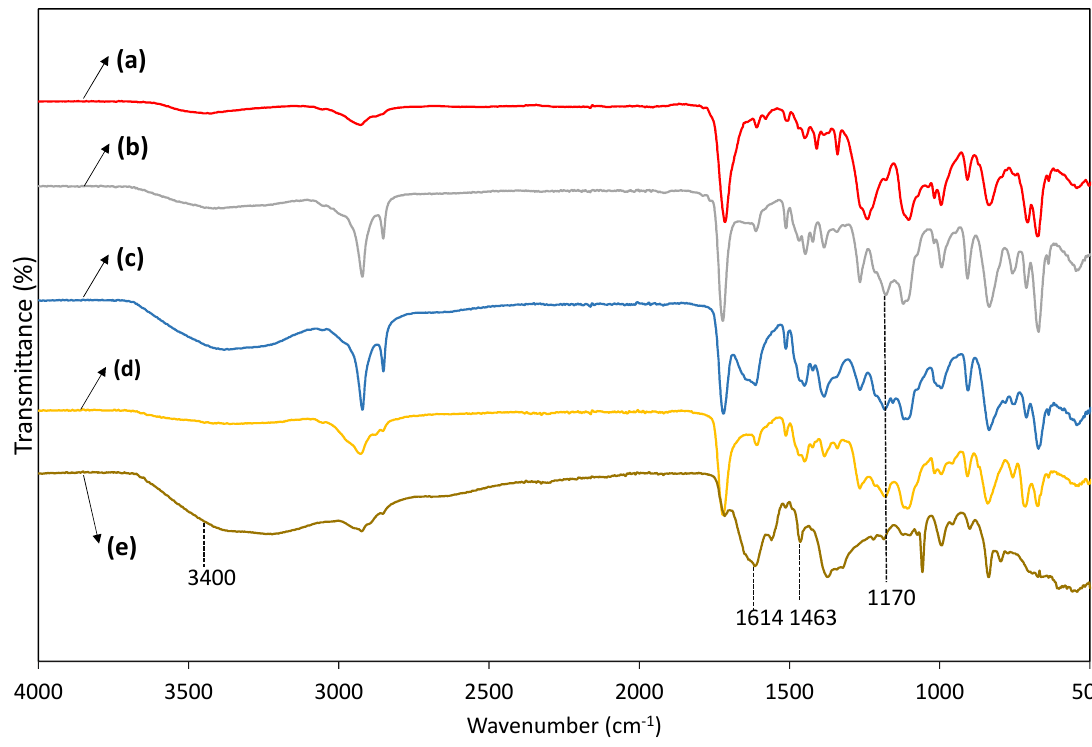
Figure 5. FT-IR spectra of ( a ) GDV45; ( b ) GDV45-TMA; ( c ) GDV45-TEA; ( d ) GDV45-TPA; and ( e )